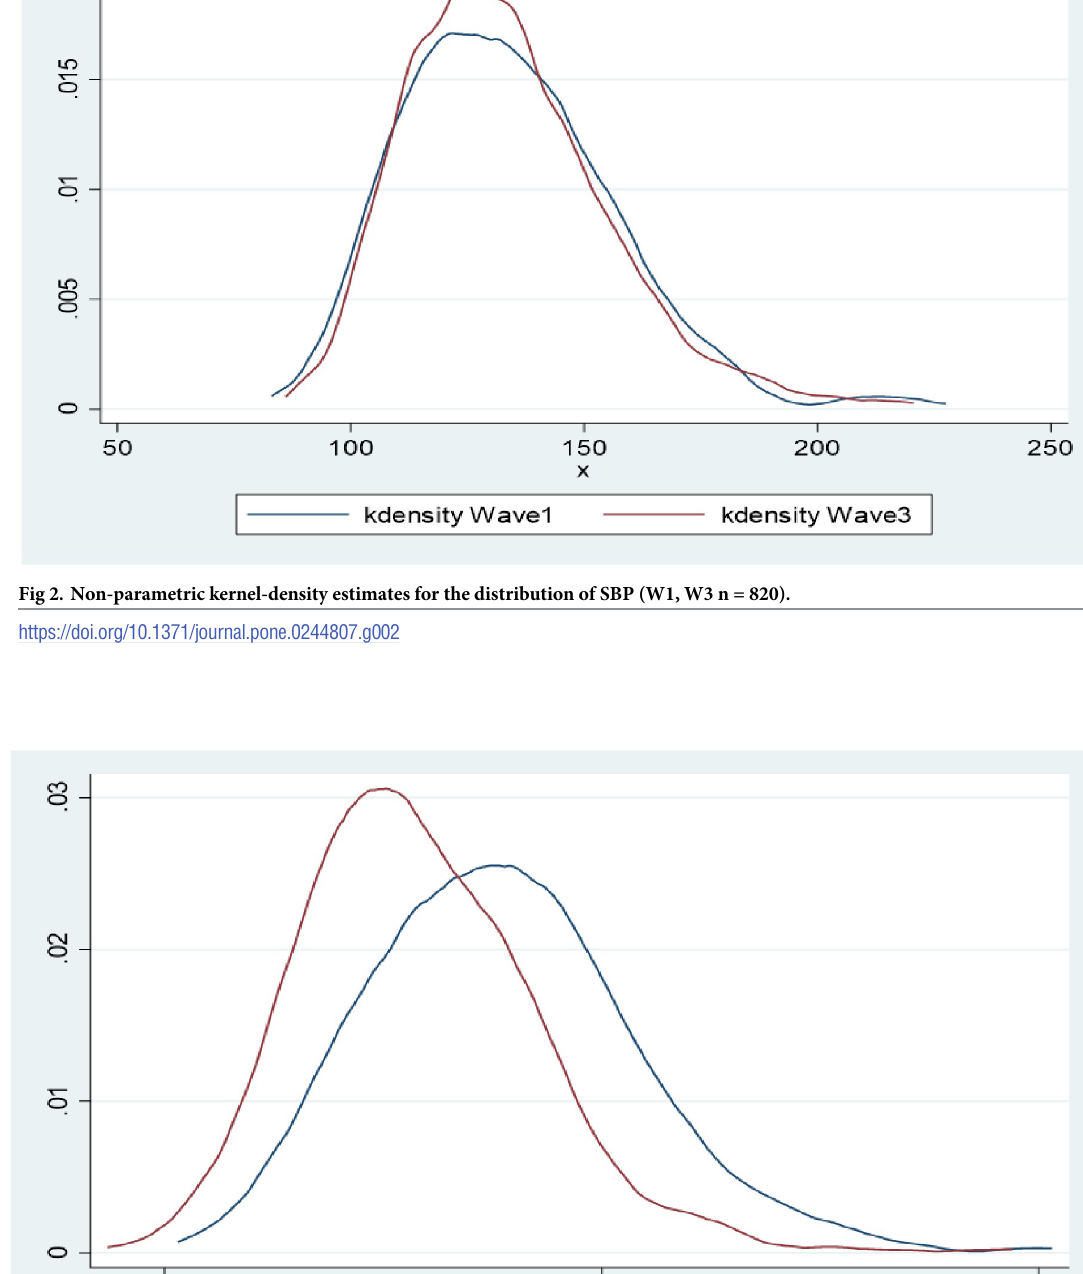
PLOS ONE | https://doi.org/10.1371/journal.pone.0244807 January 8,